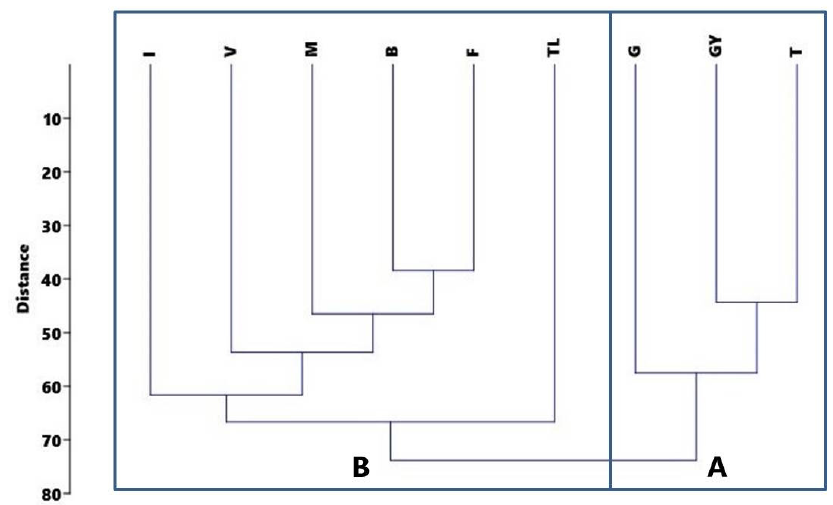
Figure 2. UPGMA analysis of the study sites’ vegetation: boxes—main distinct groups.